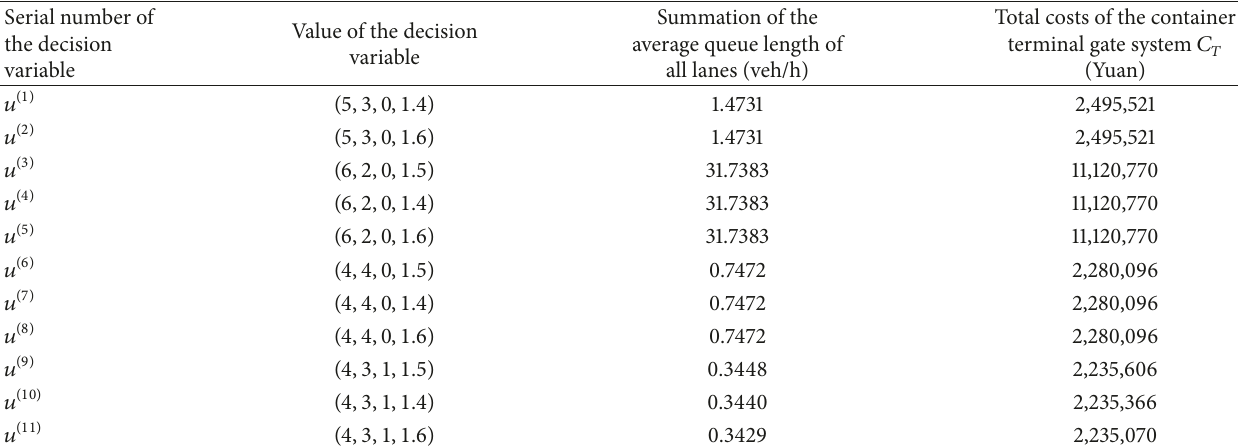
Table 3: The summation of the average queue length of all lanes and the total costs of the container terminal gate system corresponding to different solutions.